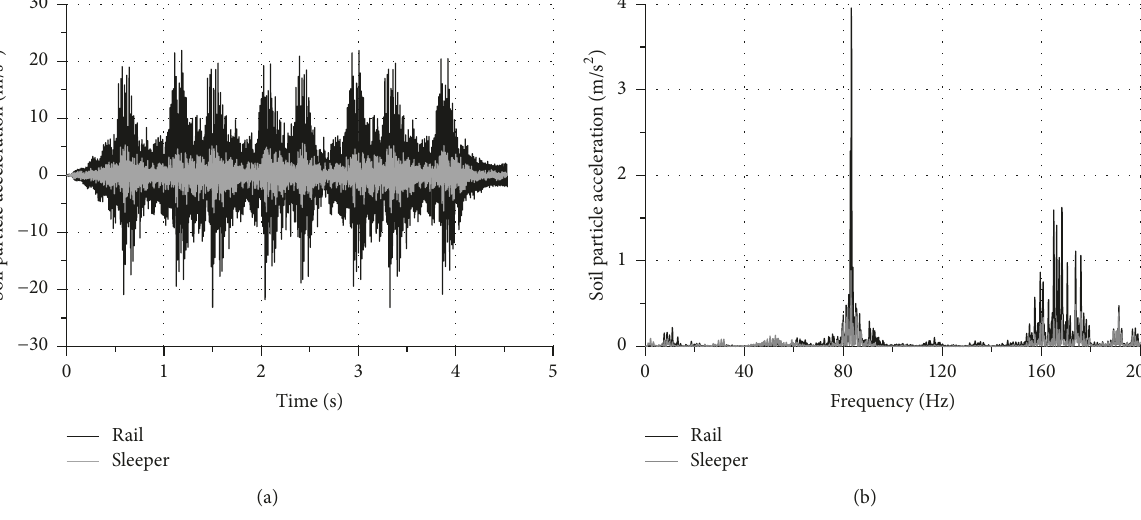
Figure 7: Acceleration comparison on the rail (black) and over a sleeper